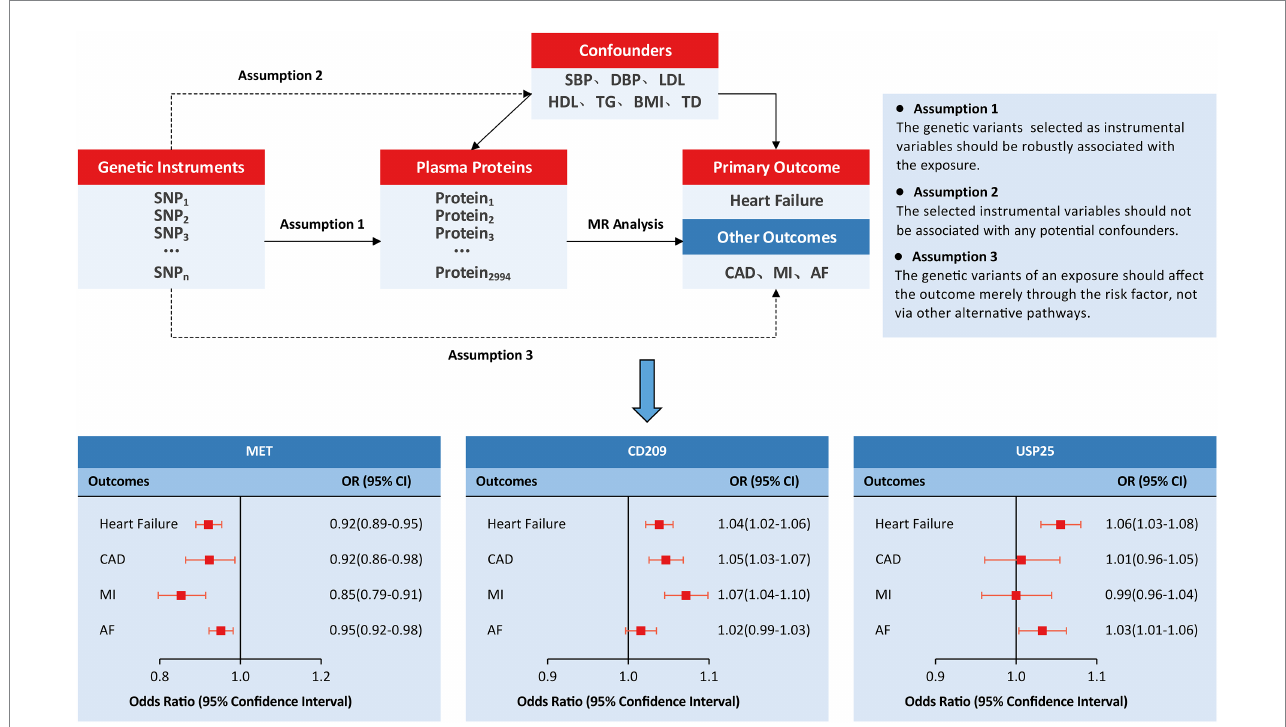
FIGURE 1 Study design and principal findings of the MR investigation. AF, atrial fibrillation; CAD, coronary artery disease; MI, myocardial infarction.